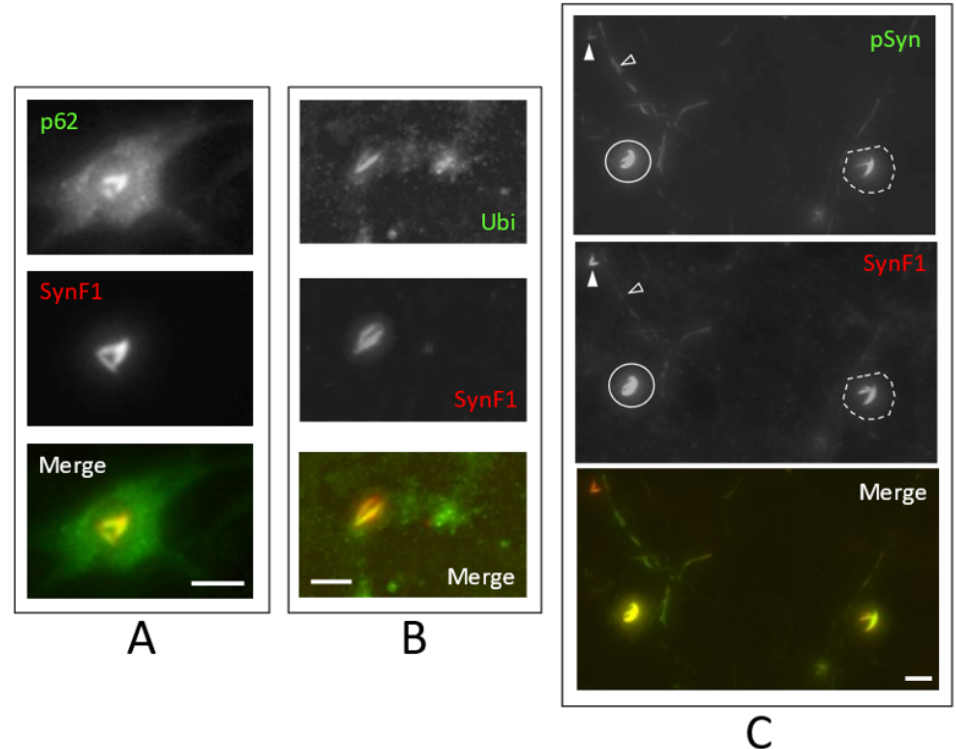
Figure 6. The 20x HCA images of 30 DIV mouse primary cortical neurons treated at DIV7 with 1B fibrils. SynF1: fibrillar α -Syn; Ubi: ubiquitin; pSyn: phospho-S129 α -Syn. For description of ( A – C ) see text. Scale bar: 10 μ m.